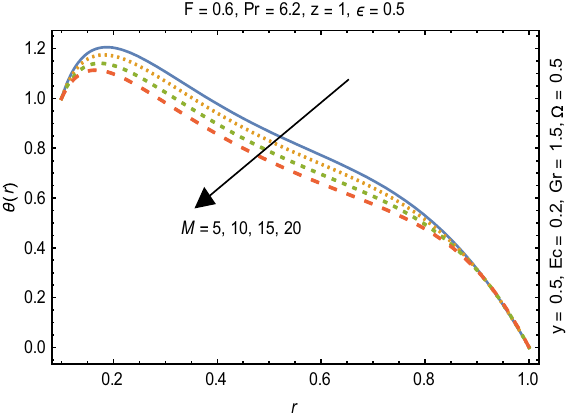
Figure 5. Variation in θ (r) against M.